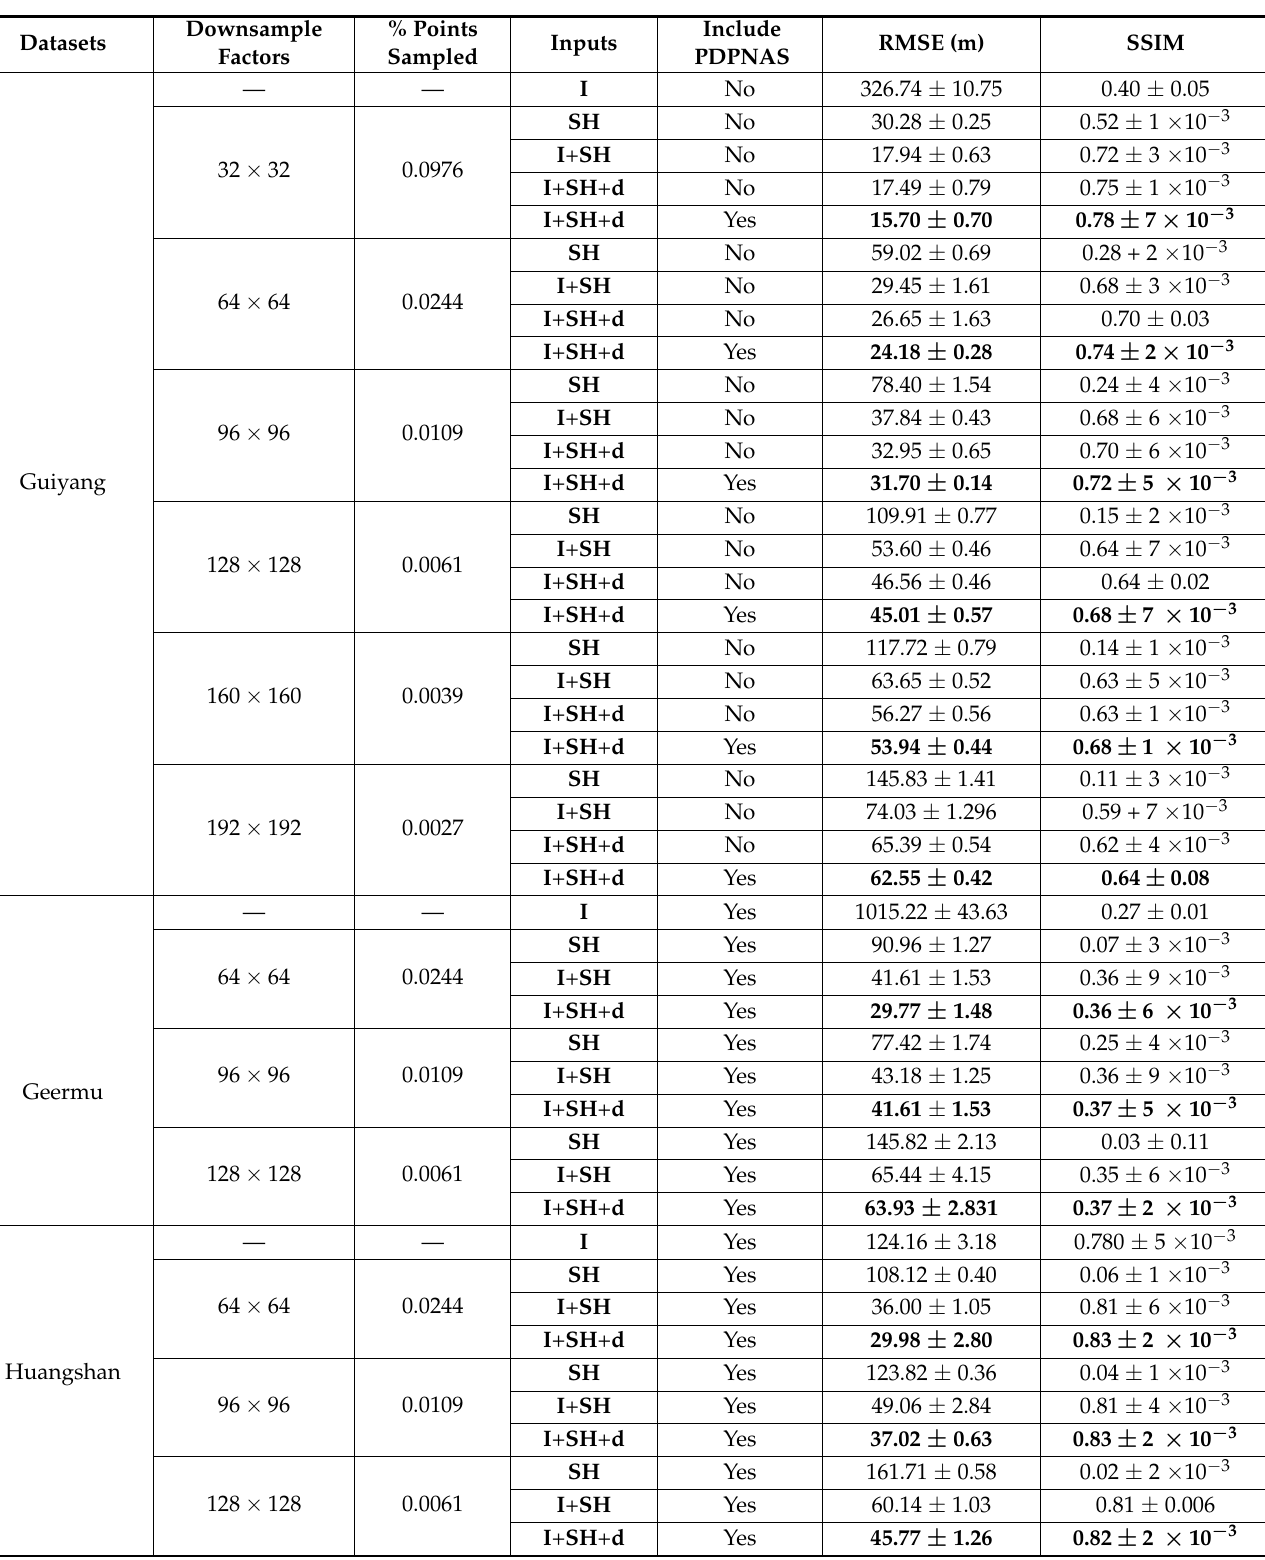
Table 2. Comparison experimental results on the supplementary inputs of sparse height information (SH), distance map (d) and PDPNAS for Unet on three